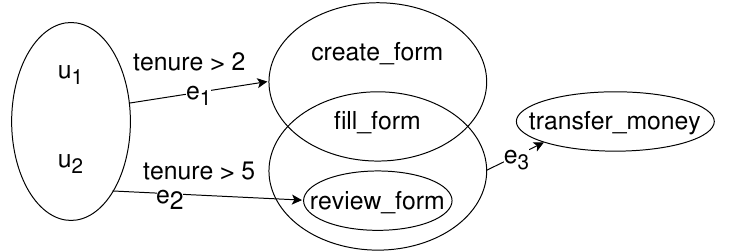
Figure 7. A simple example of conditional metagraph to model the following question: what are the necessary tasks for employees to perform a bank